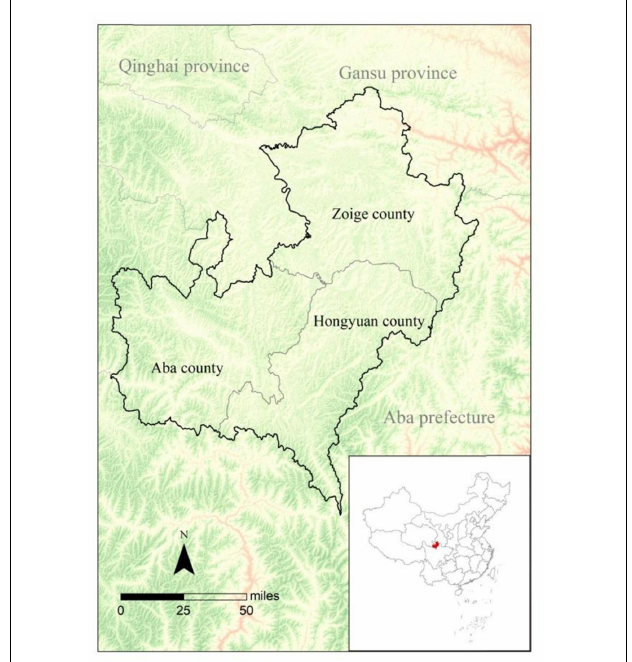
FIGURE 1 | Location of the study